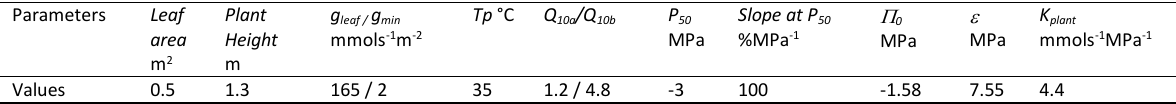
Table 1. Main characteristics of the reference simulation use for the control plant.